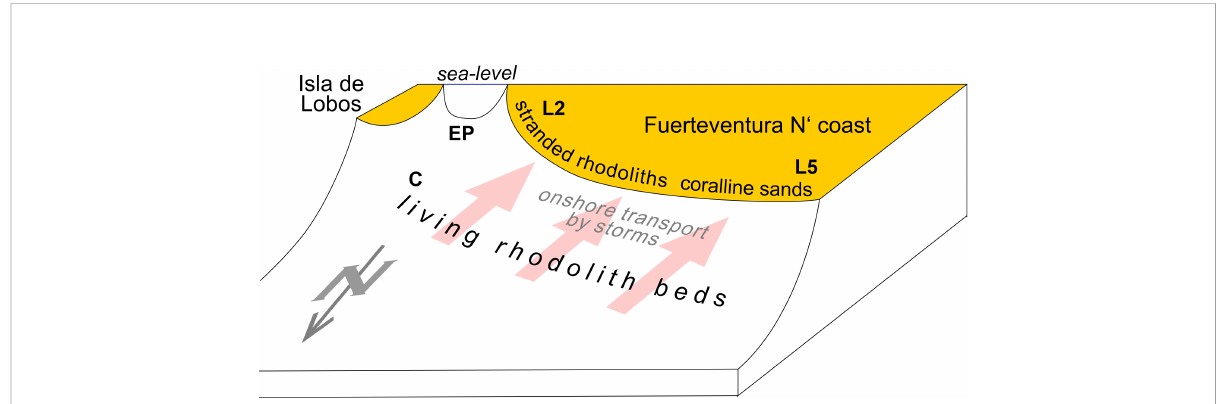
FIGURE 9 Model for the deposition of the rhodoliths on the north coast of Fuerteventura Island. L2 - Caleta del Bajo de Mejillones, L5 - Caleta de Beatriz, C – Calamareo, EP – El